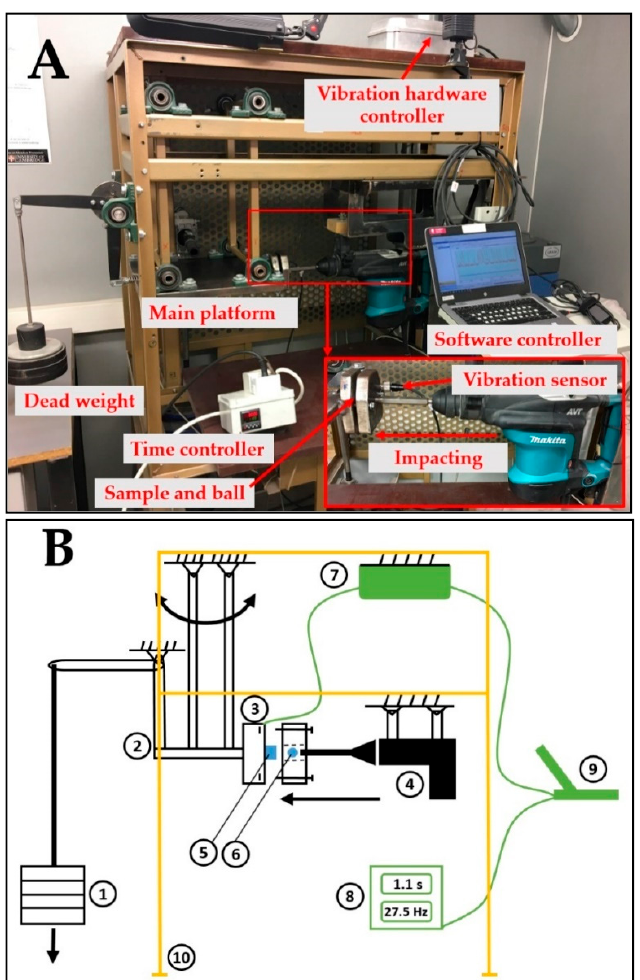
Figure 4. Impact test device: ( A ) Configuration, ( B ) schematic (1. Dead weight, 2. Main platform, 3. Holder of sample, 4. Impacting device, 5. Disk-shape sample, 6. Ball, 7. Sensor hardware, 8. Time controller, 9. Personal computer, and 10. Device structure).